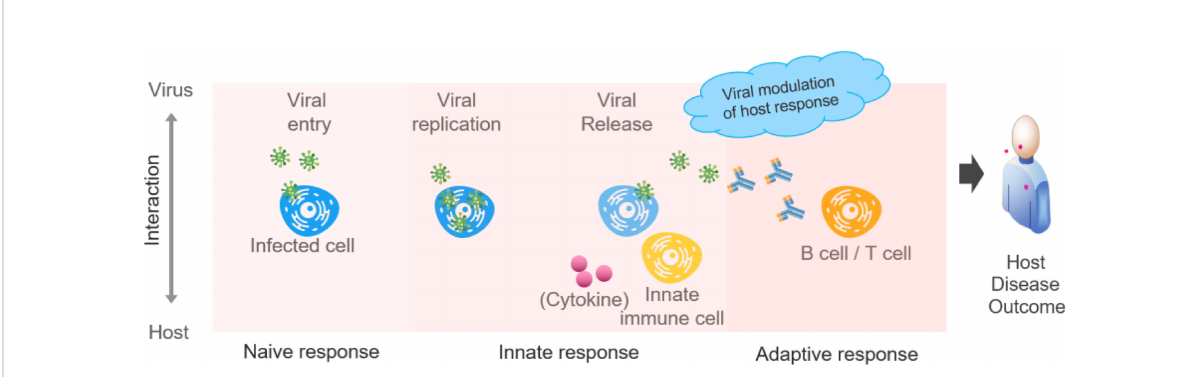
FIGURE 2 Model of host-coronavirus interactions and associated disease outcomes. The viruses enter, survive in, replicate in host cells, and may have genetic variations during the process. After initial naïve acceptance of viral entry without triggering an immune reaction (a naïve response), the host initiates active innate and adaptive responses. The host disease outcome will be determined by the dynamic host-coronavirus